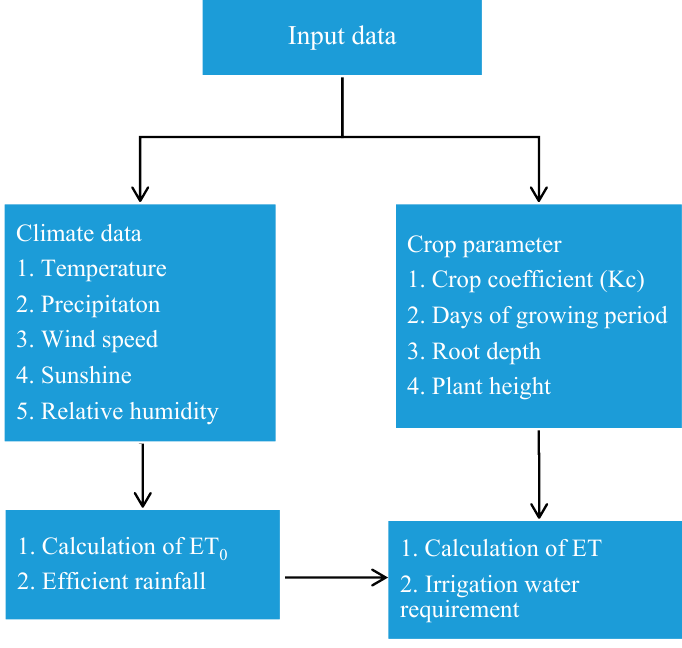
Figure 2. Flowchart describing the Crop Water Requirement (CWR) technique.